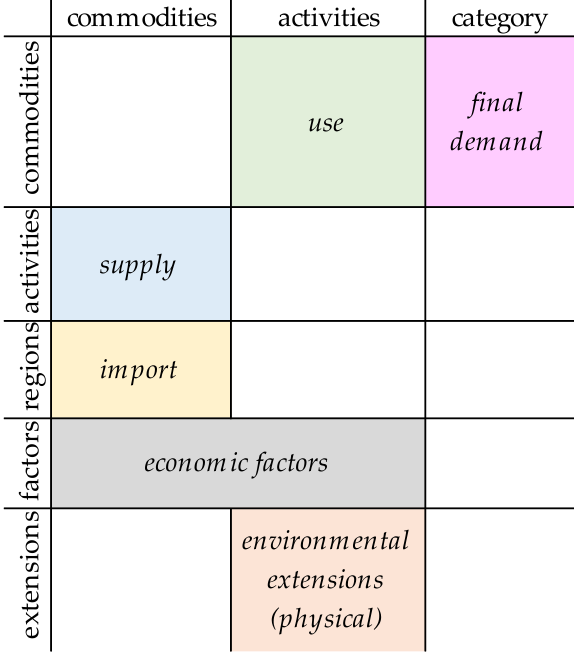
Figure 3 . Structure of the SUT input – output model adopted in this research. Figure 3. Structure of the SUT input–output model adopted in this